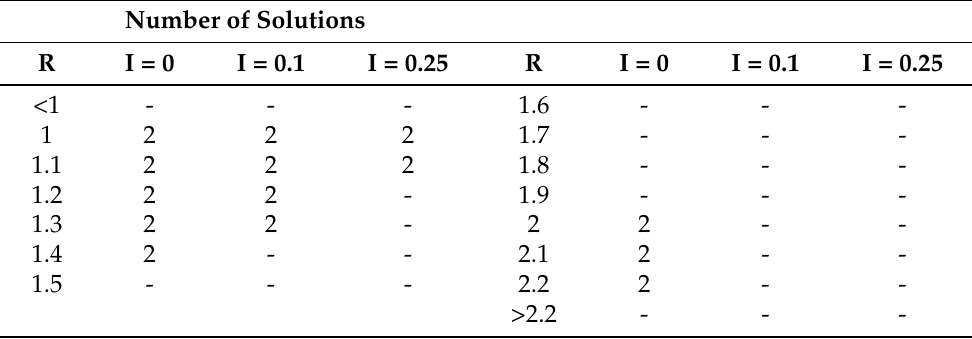
Table 3. Influence of the uncertainty on the number of solutions obtained with different coverage radius—scenario